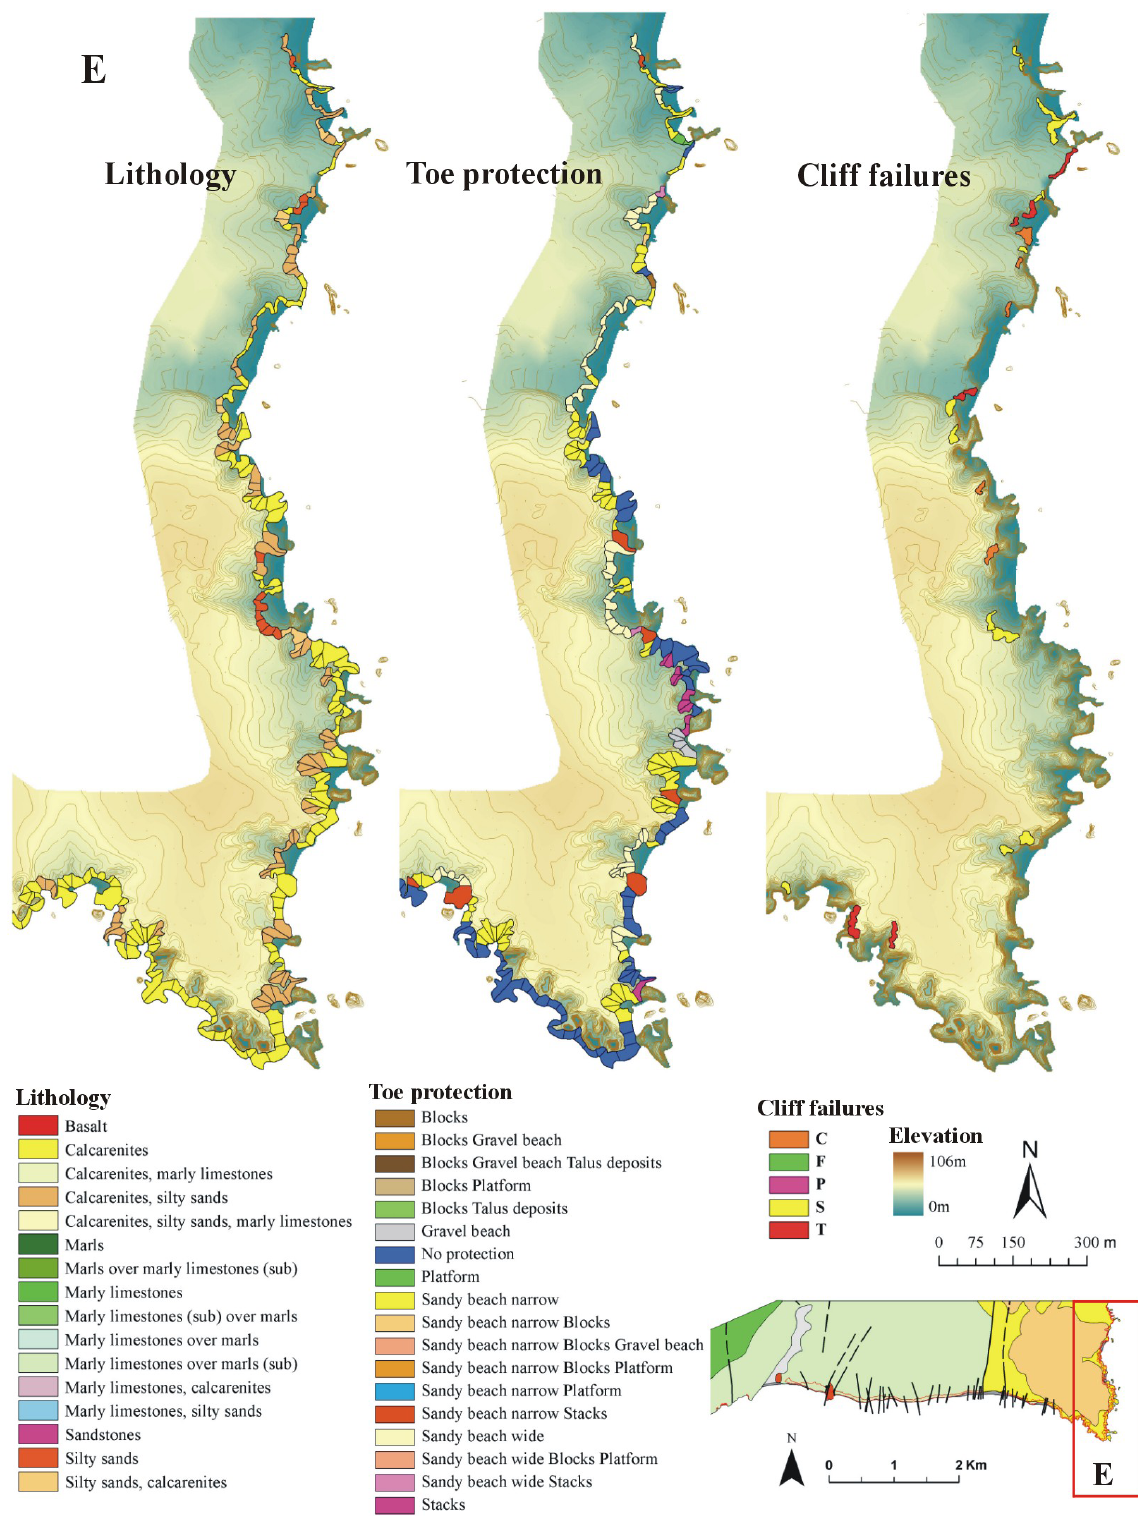
Fig. 6c. Lithology, toe protection and cliff failures in section E. Lithology and toe protection mapped according to the terrain units used in this study. Cliff failure areas are not to scale to enable visualization. Cliff failures legend: C – Complex and not determined; F – Rockfalls; P – Planar failures; S – Slumps; T – Toppling failures. Contour line interval is 2m.